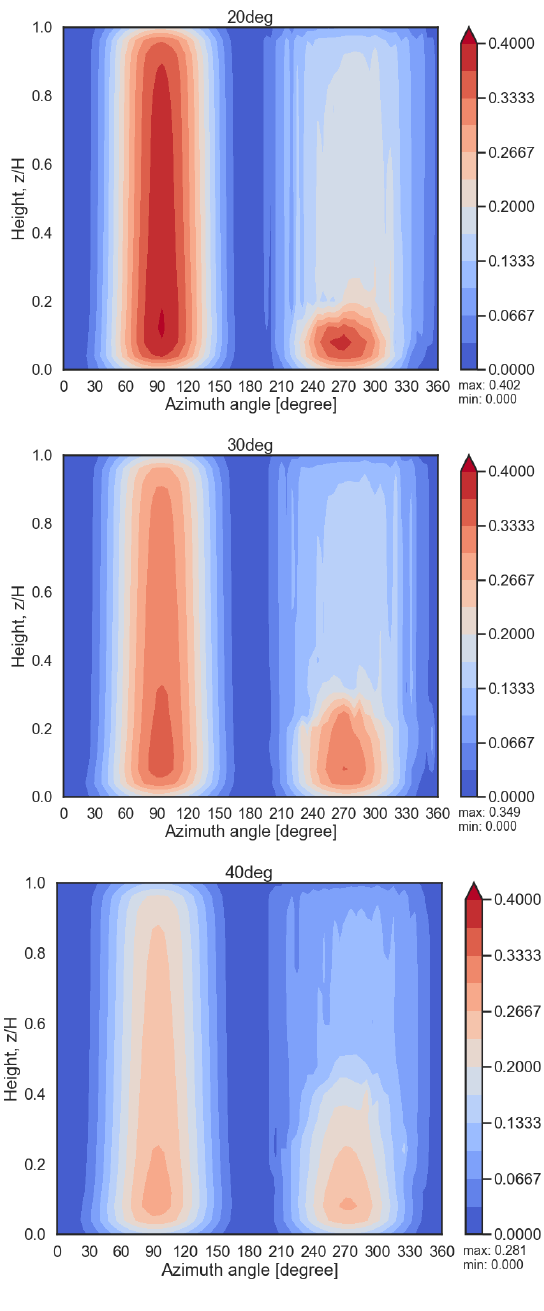
Figure 6. Contour graph of tangential blade force for 0-, 10-, 20-, 30-, and 40-degree-tilted